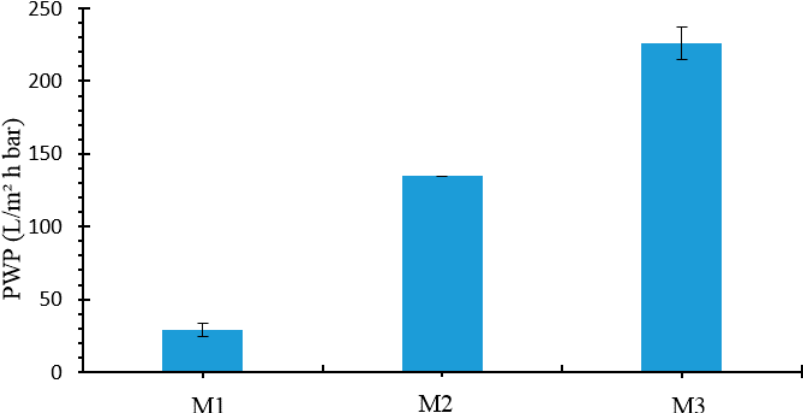
Figure 4. Pure water permeability (PWP) of membranes with different evaporation time.